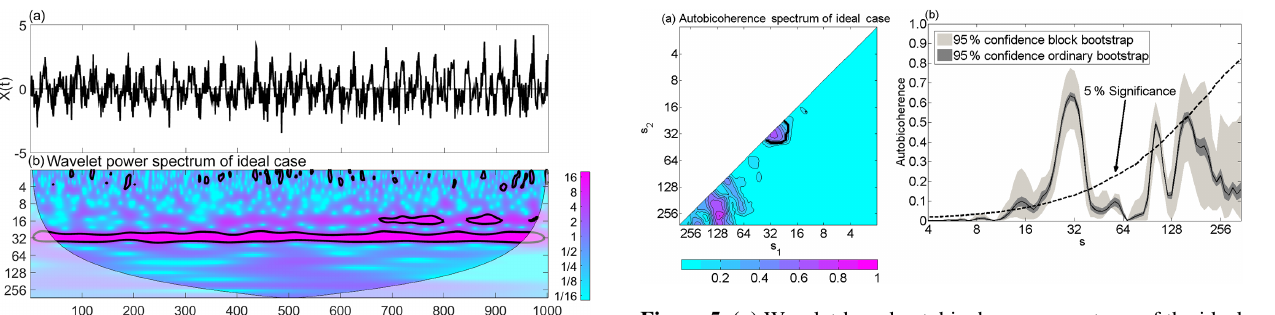
Figure 5. (a) Wavelet-based autobicoherence spectrum of the ideal time series. Thick contours enclose regions of 5% pointwise sig- nificance after controlling the FDR. The diagonal line separates the spectrum into two symmetric regions. (b) The diagonal slice of the autobicoherence spectrum at s 1 = s 2 = s . The critical level for the test represented by the dotted line was calculated using Monte Carlo